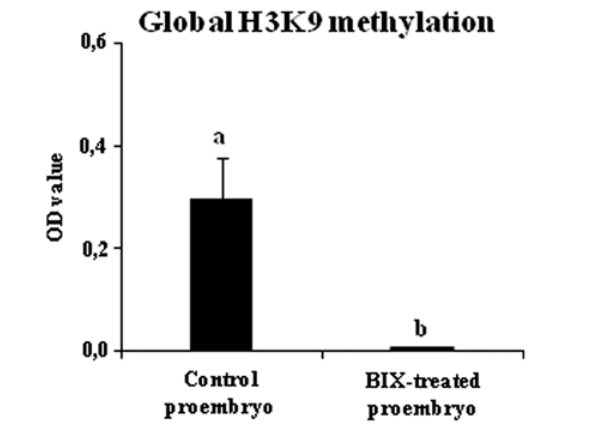
FIGURE 9 | Effects of BIX-01294 short treatments on H3K9 methylation levels of proembryos of Brassica napus . Quantification of global H3K9 methylation levels, represented as mean optical density (OD) units at 450 nm ( ± SEM), in control (untreated) and 2.5 µ M BIX-treated proembryos of Brassica napus , after 4 days in culture. Different letters on columns indicate significant differences according to ANOVA and Tukey’s tests at p <